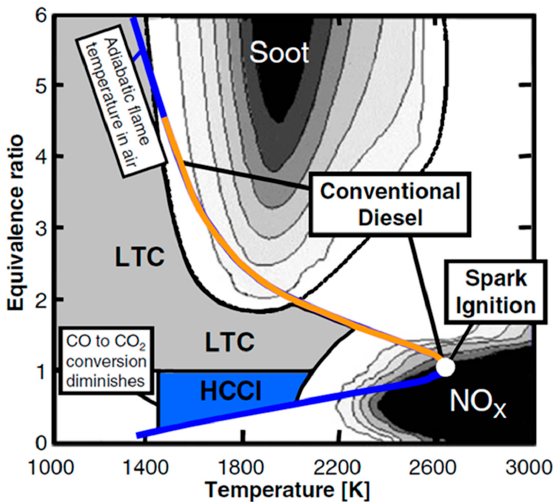
Figure 1. Soot or NOx islands, LTC and conventional CI combustion regimes in ϕ -T space [Reprinted from Proceedings of the Combustion Institute, Vol. 32, John E. Dec, Advanced compression-ignition engines—understanding the incylinder processes, Copyrights (2009); with permission from Elsevier].